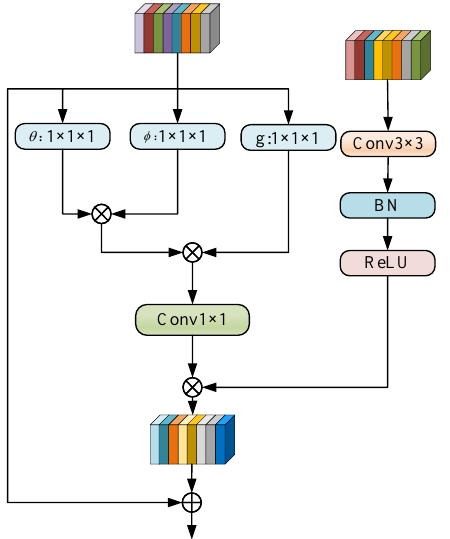
Figure 6. Feature Fusion Upsample module. 1 × 1 × 1 means 1 × 1 × 1 convolutions. BN is the batch normalization